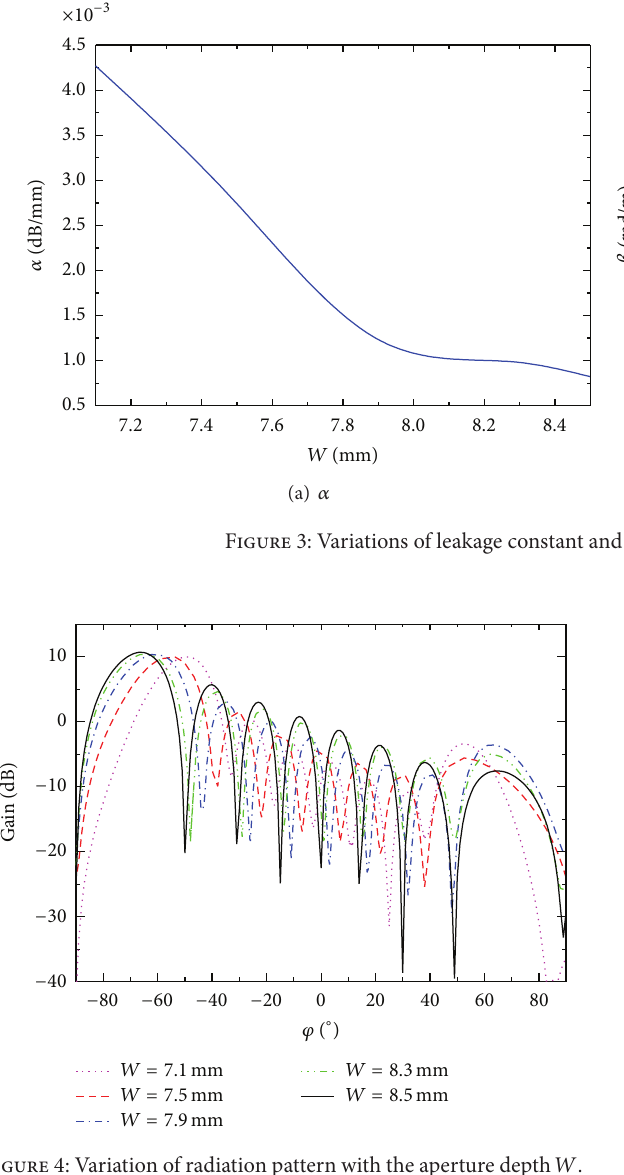
Figure 4: Variation of radiation pattern with the aperture depth 𝑊 .